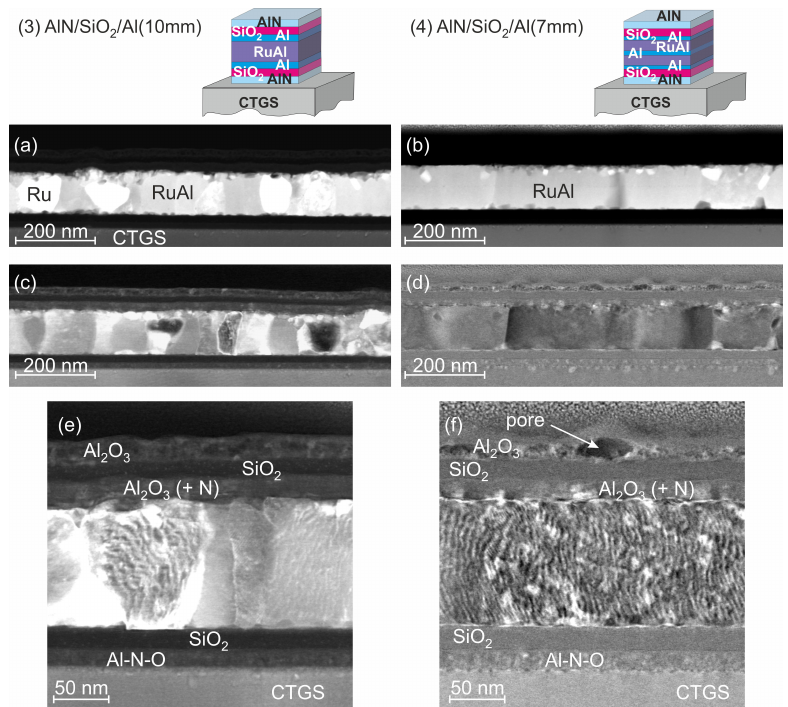
Figure 11. STEM images of layer stacks (3)-AlN/SiO 2 /Al(10 nm) and (4)-AlN/SiO 2 /Al(7 nm) on CTGS after annealing at 800 ◦ C in air: ( a , b ) with predominant chemical contrast and ( c – f ) with predominant orientation